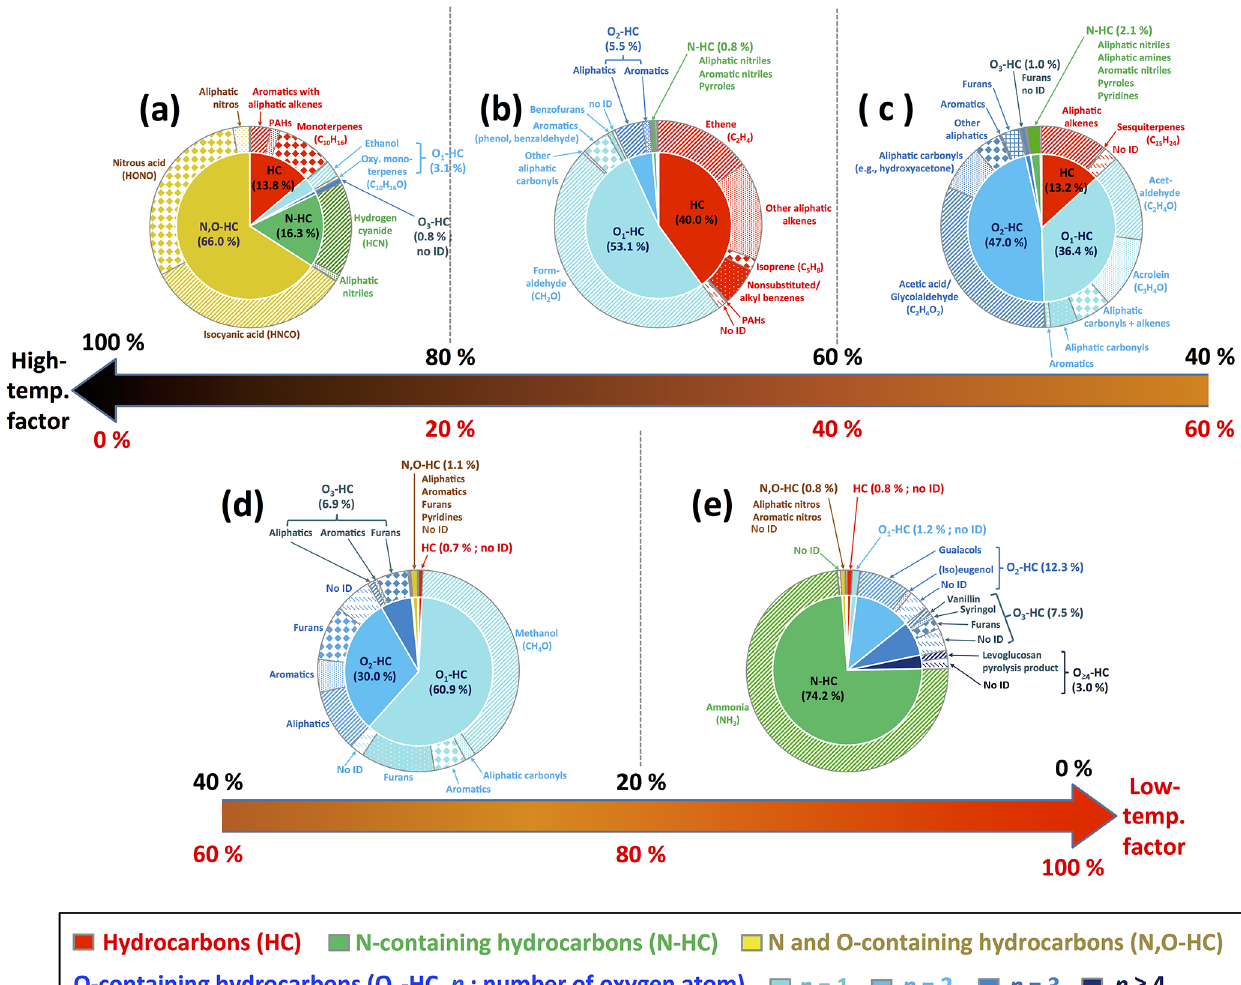
Figure 5. Contributions, shown as normalized fractions, of VOCs relative to the high- and low-temperature factors: (a) F High- T = 100–80 and F Low- T = 0–20%, (b) F High- T = 80–60 and F Low- T = 20–40%, (c) F High- T = 60–40 and F Low- T = 40–60%, (d) F High- T = 40–20 and F Low- T = 60–80%, and (e) F High- T = 20–0 and F Low- T = 80–100%. In this figure, molar emissions (in units of ppbv) of all the ion peaks in VOC emission profiles (Fig. 2b) are described. The inner circle in each pie chart shows the elemental composition of the emissions. The outer circle provides more detailed information on specific compounds, structures, and functionalities found in each group. Details of molar fractions in each category are summarized in Table